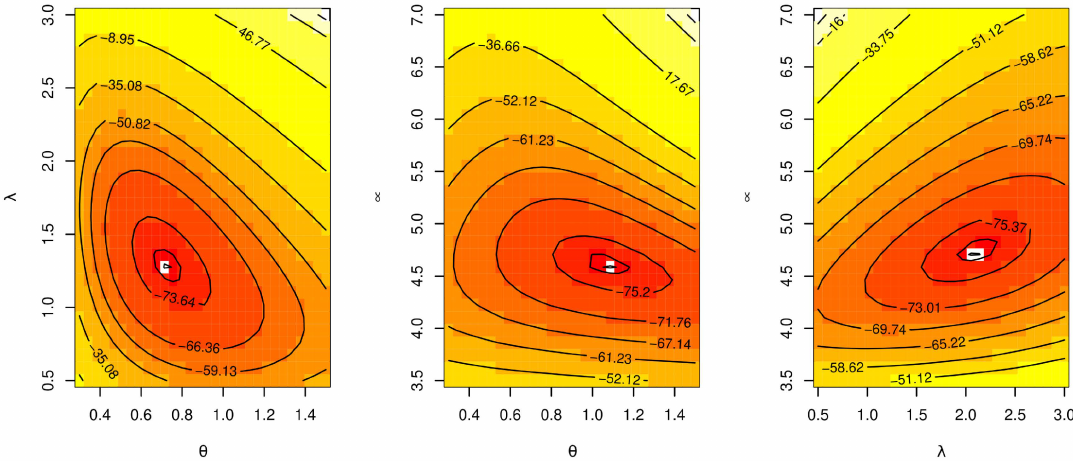
Figure 17. Contour plot for log-likelihood of the TCPWE distribution for COVID-19 data.